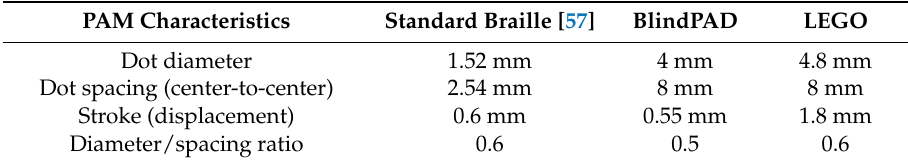
Table 1. Physical characteristics of dots in three different technologies: BlindPAD shares a similar resolution to LEGO dots, but with a stroke similar to Braille dots and a diameter/spacing ratio common to both